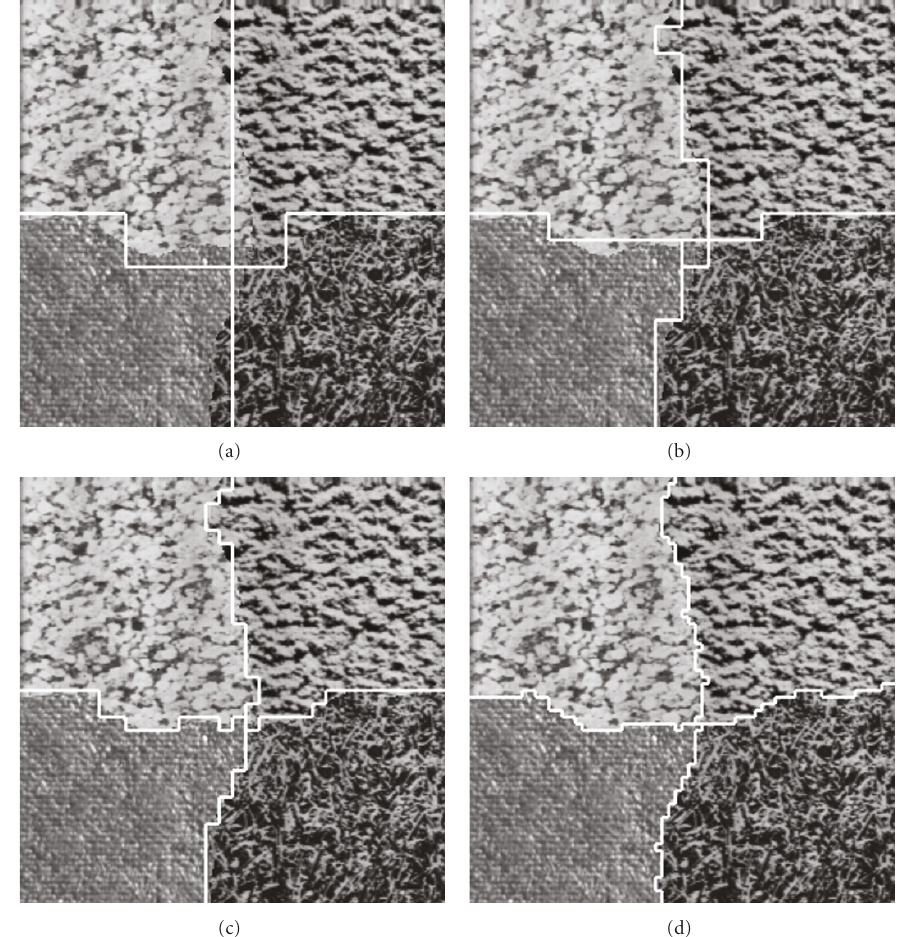
Figure 6: Segmentation results of Image III at 3 di ff erent resolution levels.